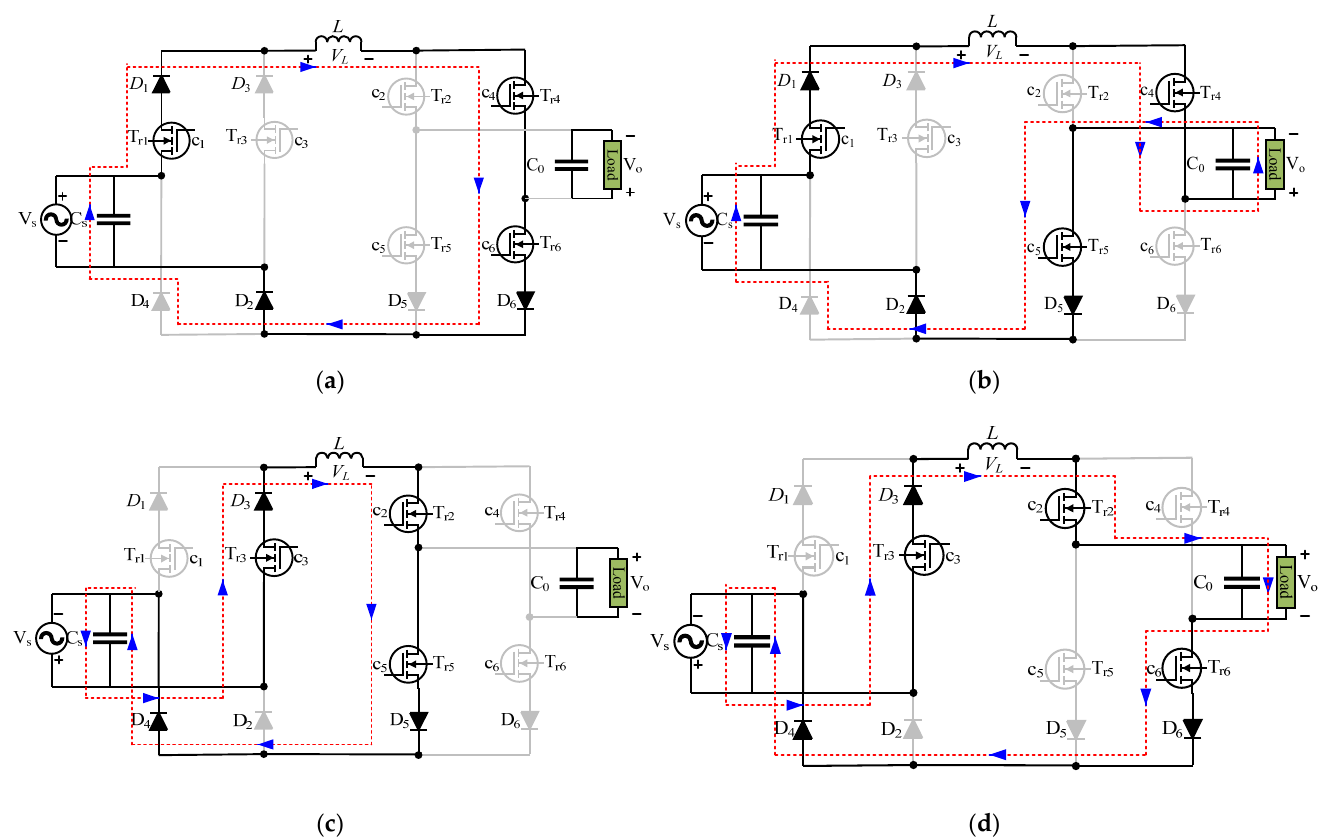
Figure 8. Equivalent power transfer loops formed by PWM control to have inverted voltage boost output for half cycles of ( a ) and ( b ) positive source voltage; ( c ) and ( d ) negative source voltage.